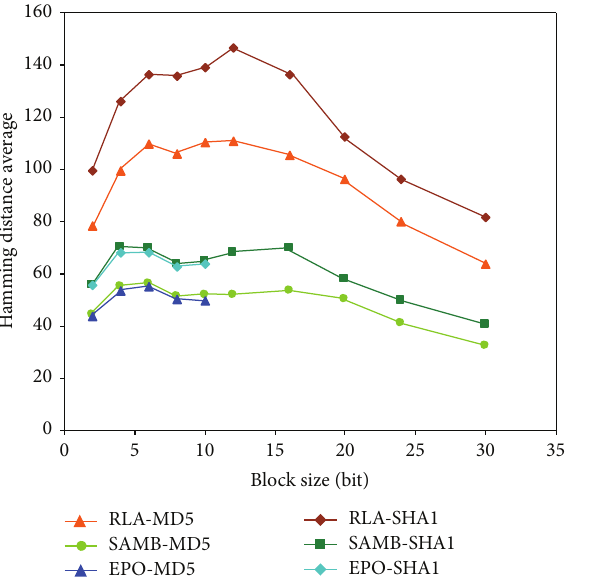
Figure 4: Computation time for EPO and SAMB